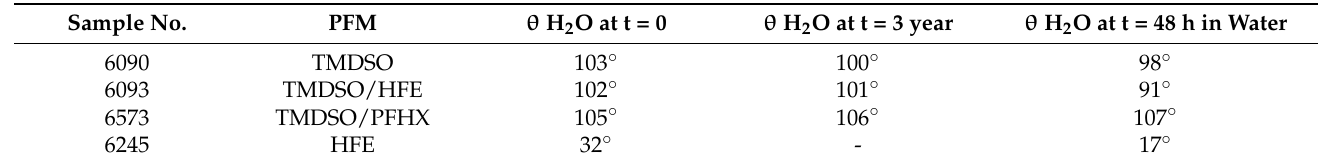
Figure 5. SEM of uncoated PP150/330 (7905 reflects the batch of uncoated membrane). Table 5. Contact angle with water of plasma polymer coatings on microglass